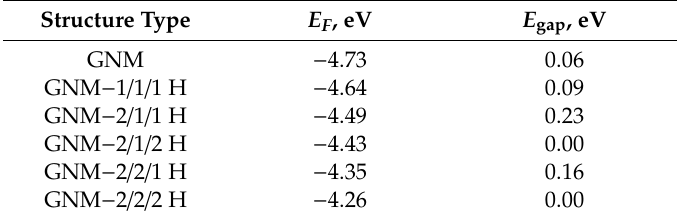
Table 1. Energy characteristics of GNM with various types of hydrogenation of the nanohole